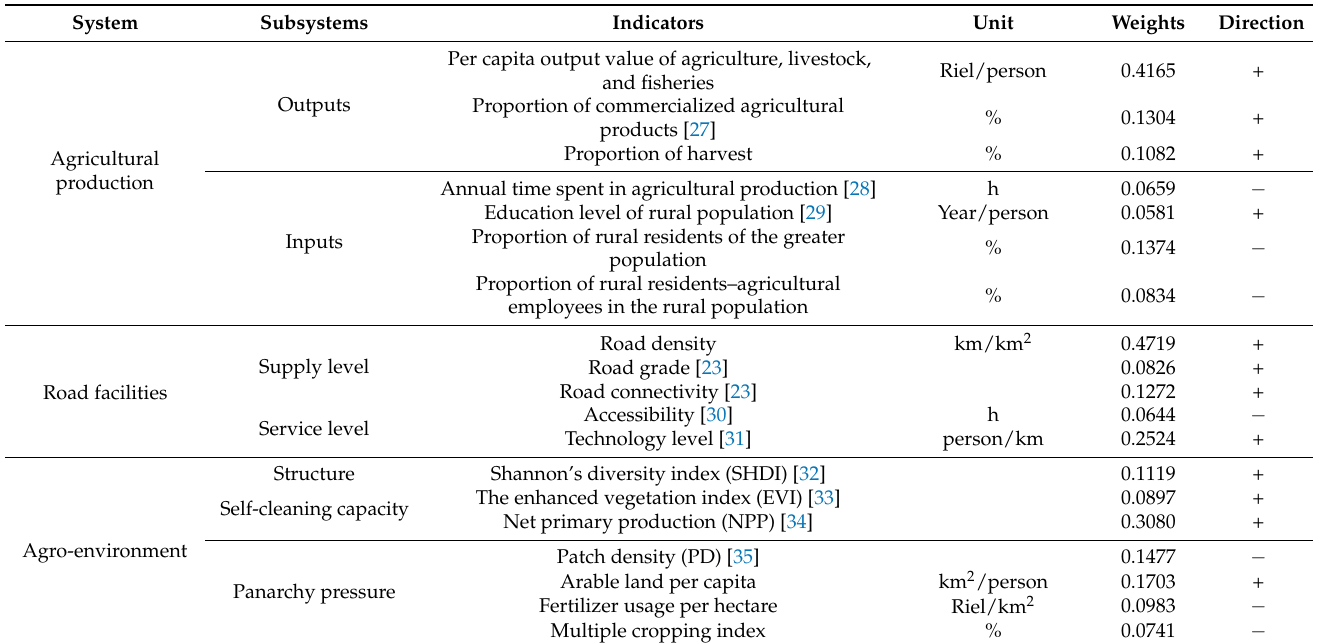
Table 1. Agricultural production, regional road construction, and agricultural eco-environment evaluation index